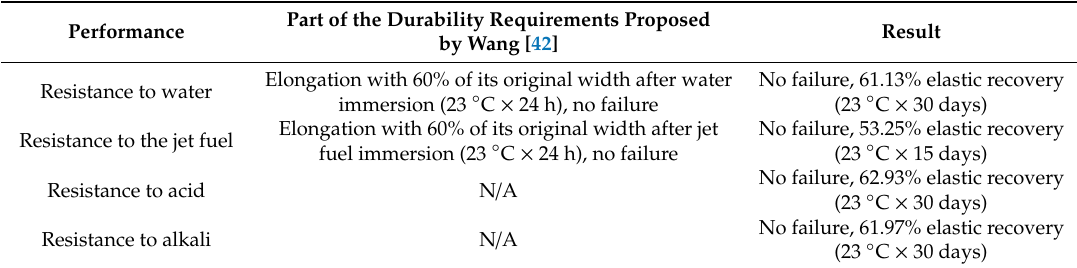
Table 4. Durability test results of the